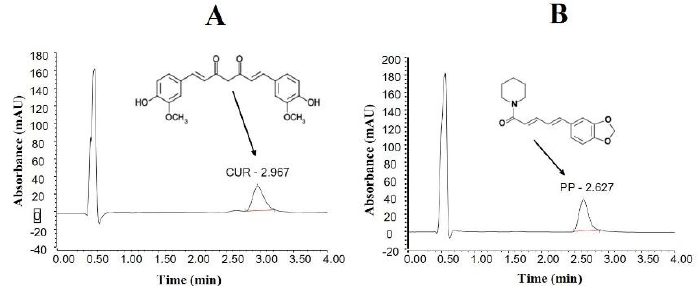
Figure 1. UHPLC chromatograms and chemical structures of ( A ) curcumin and ( B ) piperine in a self-nanoemulsifying lipid formulation sample. CUR denotes curcumin and PP: piperine.